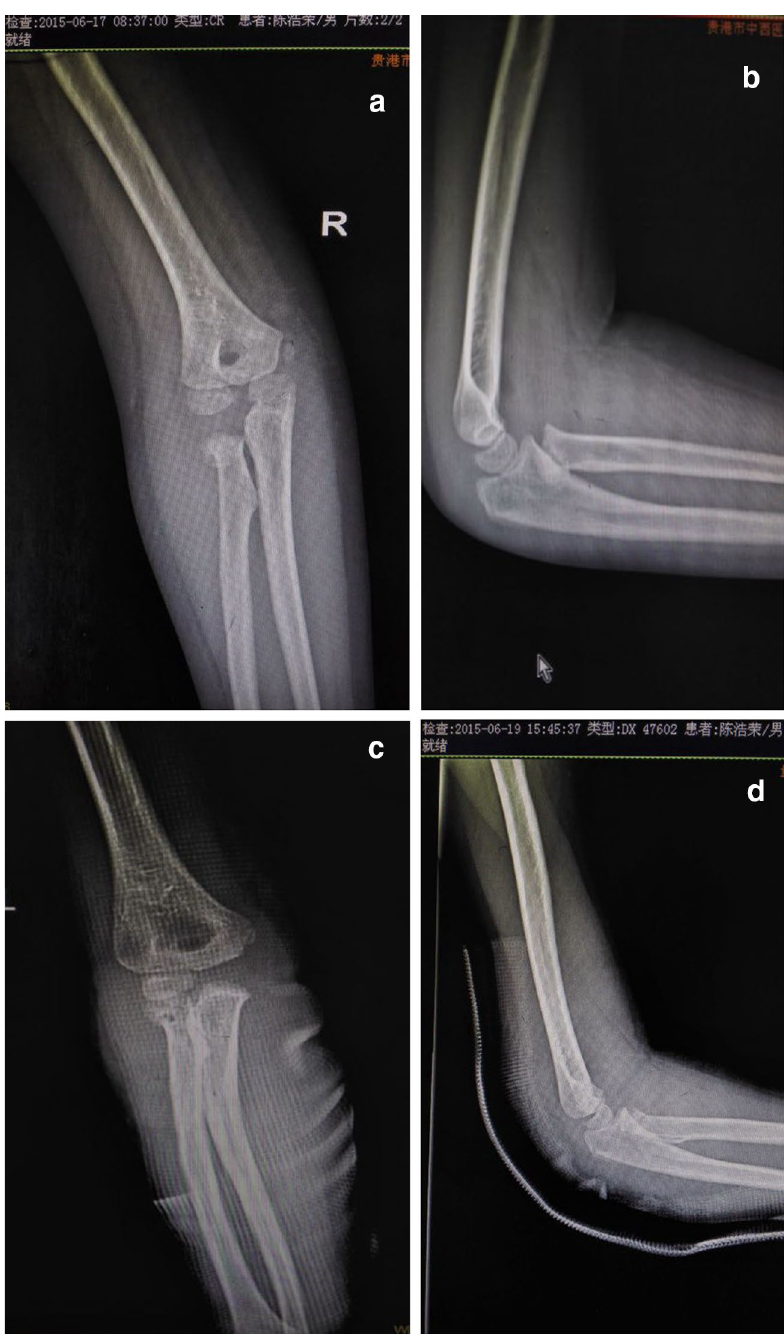
Figure 2. 5-year-old boy, right radial neck fracture, type I, plaster fixation ( A) and ( B ) preoperative , ( C ) and ( D )